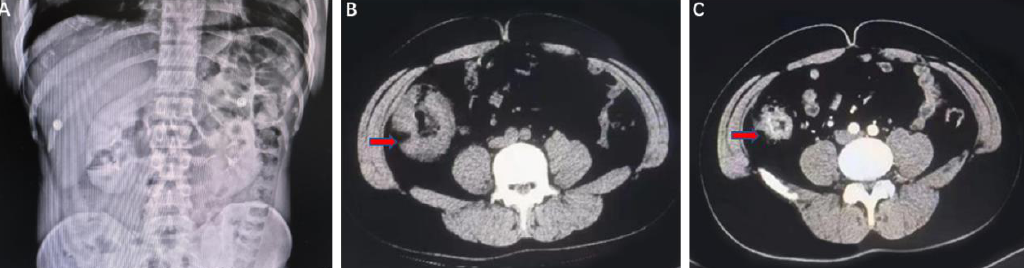
Figure 1. Imaging evaluation before and after treatment. Multiple gas accumulation in the intestinal cavity before treatment shown by CT scanning ( A ); Tumor mass in the ascending colon as indicated by red arrows ( B ), and significantly reduced after three cycles of immunotherapy ( C